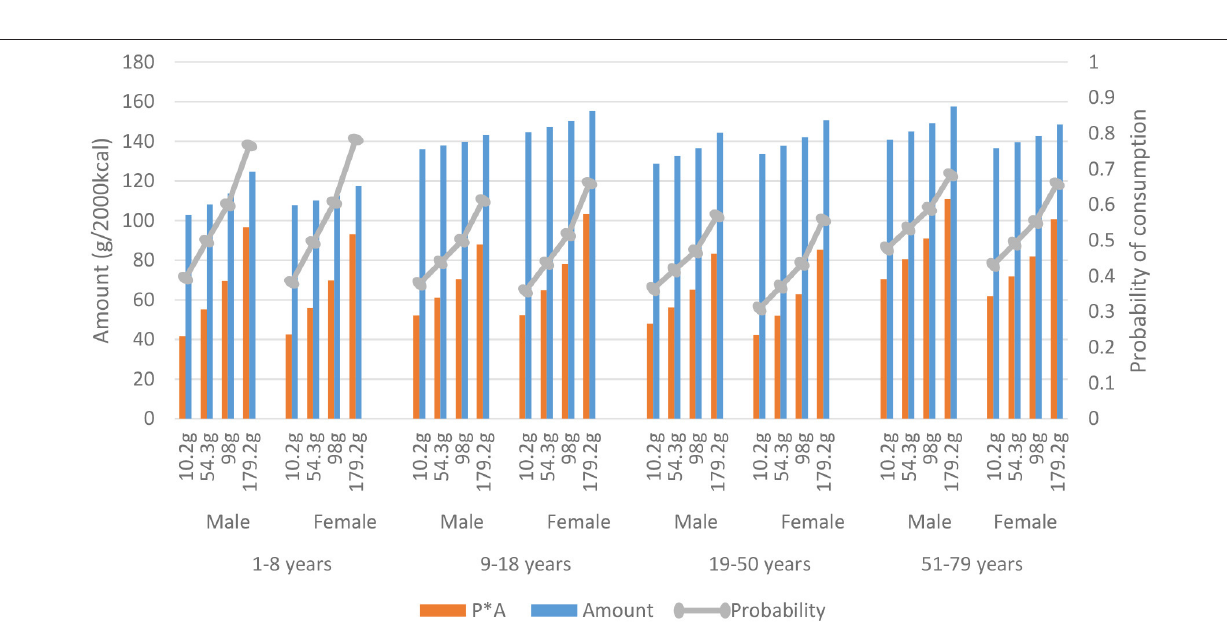
FIGURE 4 | Consumption of potatoes presented by mean total meat consumption per quartile, gender, and age. The predicted quantity (P*A) (g/2,000 kcal) is the modeled amount among users (Amount), times the modeled probability of consumption (probability) derived from the Dutch National Food Consumption Survey